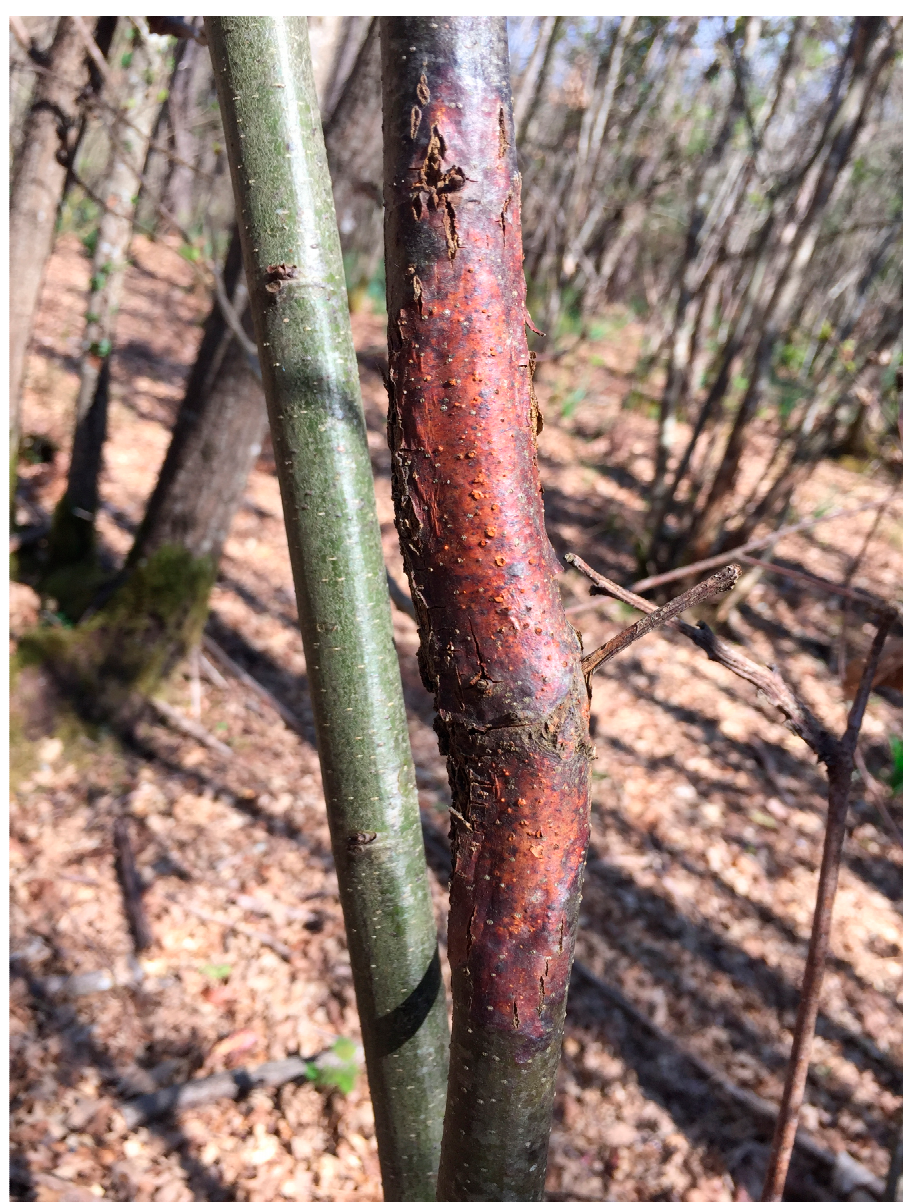
Figure 1. A canker on the stem of a young European chestnut ( Castanea sativa ) tree. The characteristic orange-brown discoloration of the bark, with bark cracks and yellowish-to-orange stromata containing locular pycnidia (conidiomata) are clearly visible. Under favorable moist conditions, yellow tendrils consisting of sticky conidia extrude from pycnidia.